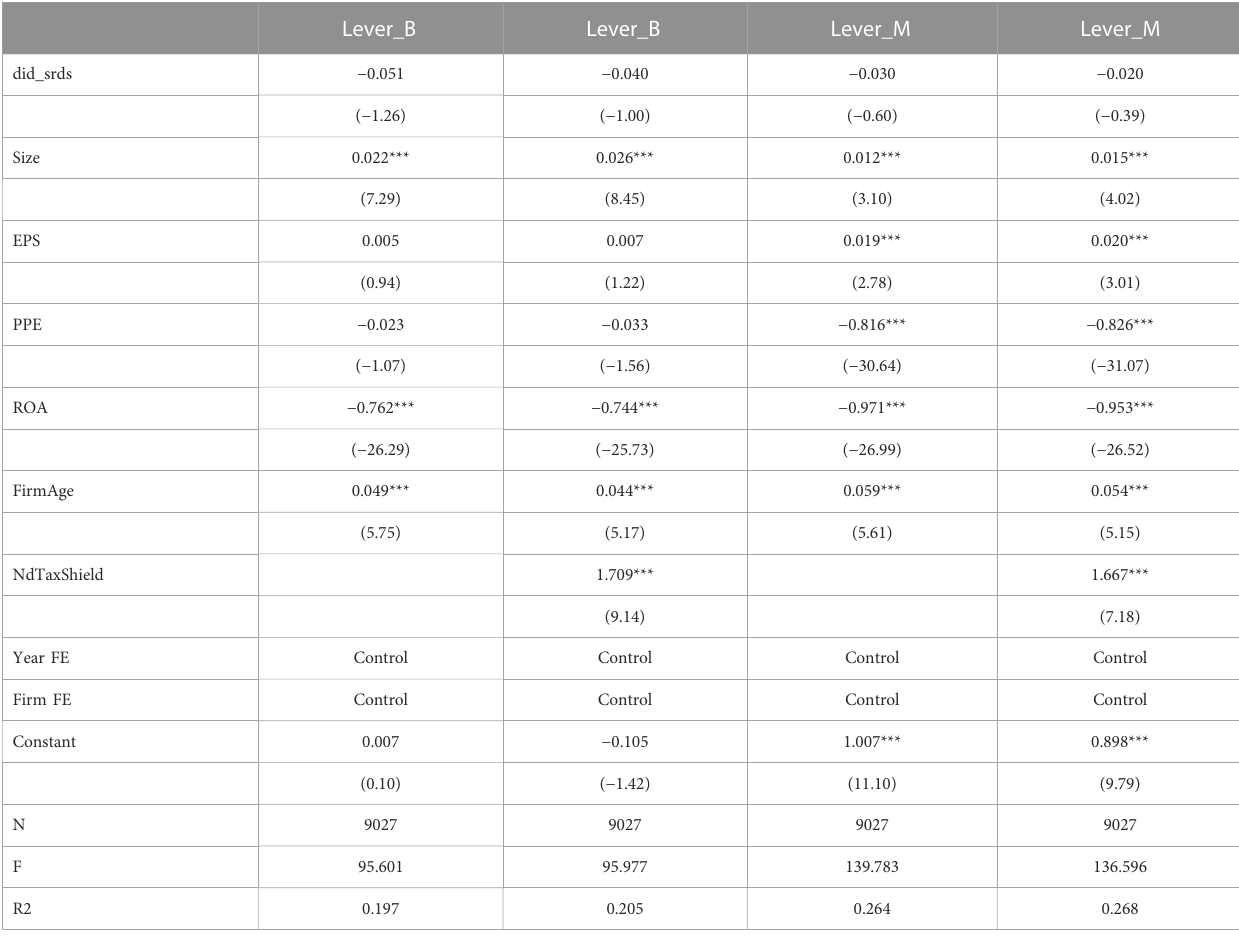
TABLE 5 Placebo test (city